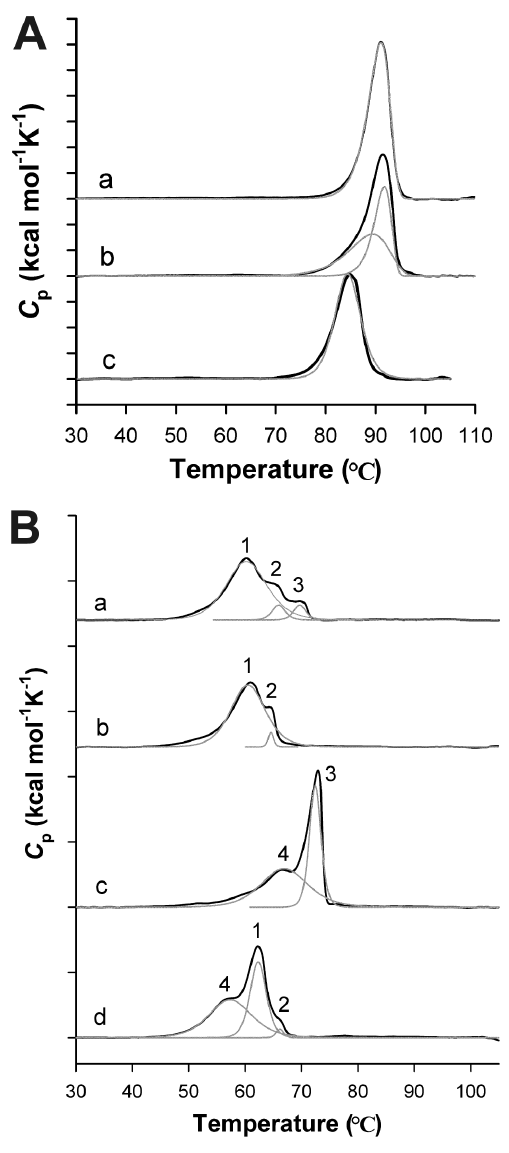
Figure 8. Thermostability of WT and RP-mutant Sc MnSOD and Ca MnSODc. The S. cerevisiae enzymes in (A) are: (a) as-isolated Sc MnSOD, (b) oxidized Sc MnSOD and (c) as-isolated K182R, A183P Sc MnSOD. The C. albicans enzymes in (B) are: (a) as-isolated Ca MnSODc; (b) reduced Ca MnSODc; (c) oxidized Ca MnSODc and (d) as-isolated K184R, L185P Ca MnSODc. Unfolding transitions are shown in black lines. The components (gray) were deconvoluted using a two-state irreversible model for WT Sc MnSOD and a non-two-state reversible model for RP-mutant Sc MnSOD, and WT and RP-mutant Ca MnSODc. Reduced or oxidized enzymes were prepared by adding sodium hyposulfite or potassium permanganate to the sample solution prior to the DSC